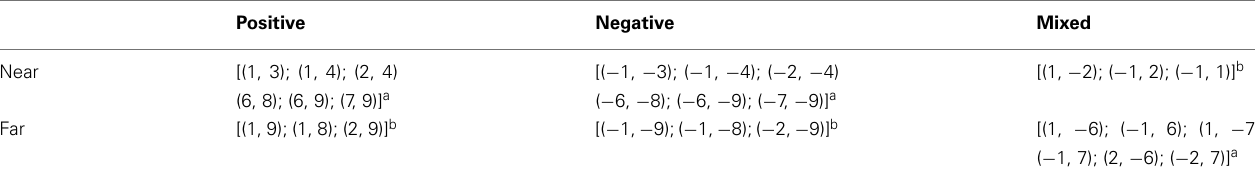
Table 1 | Experimental stimuli for each number type and distance.